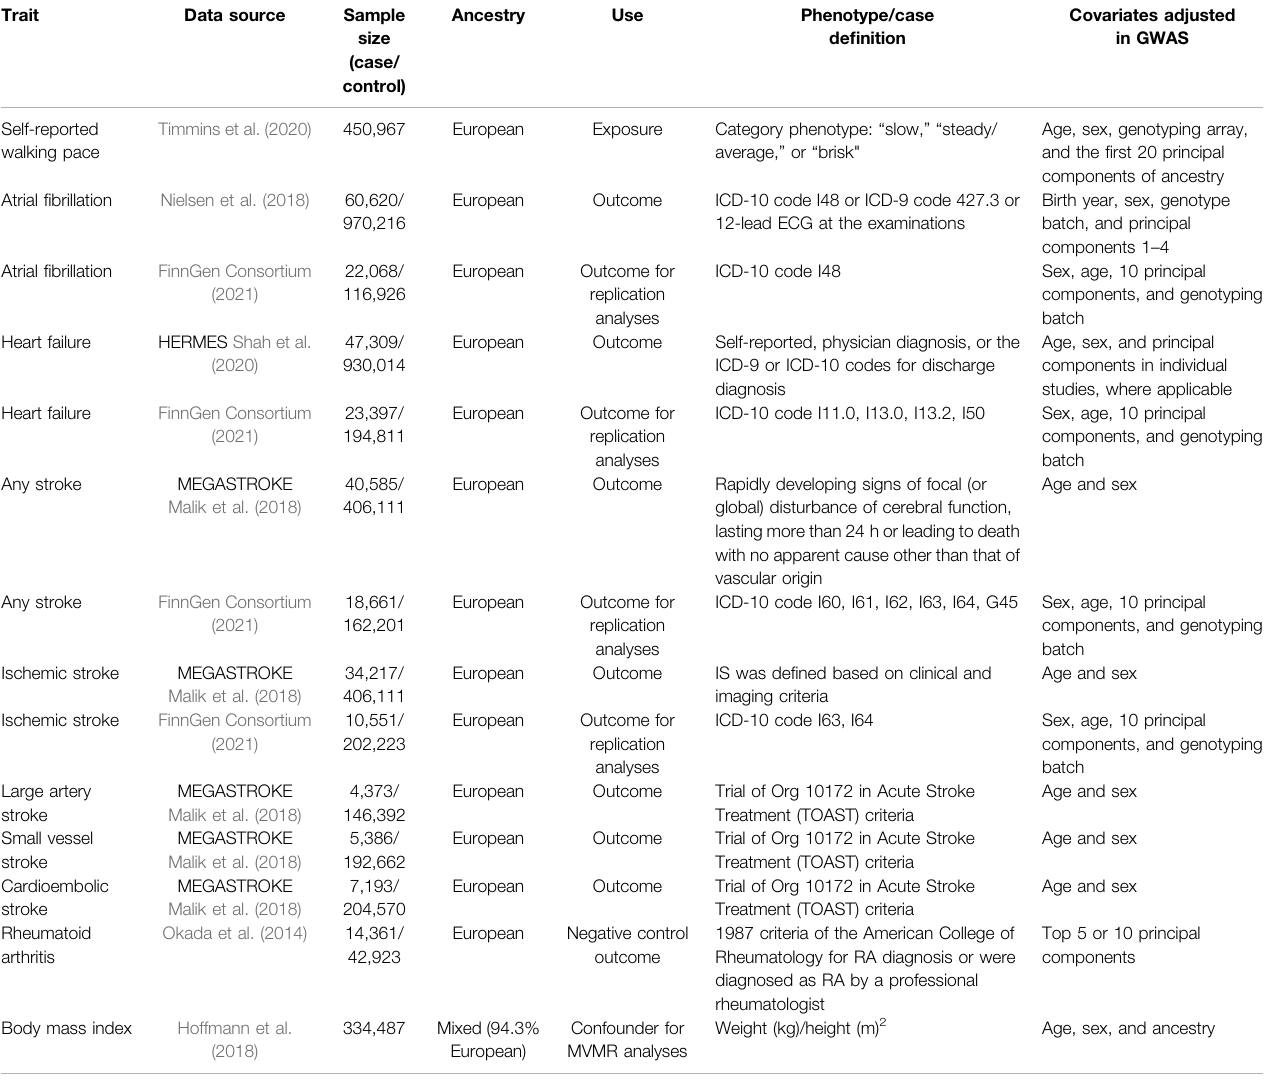
TABLE 1 | Characteristics of the data